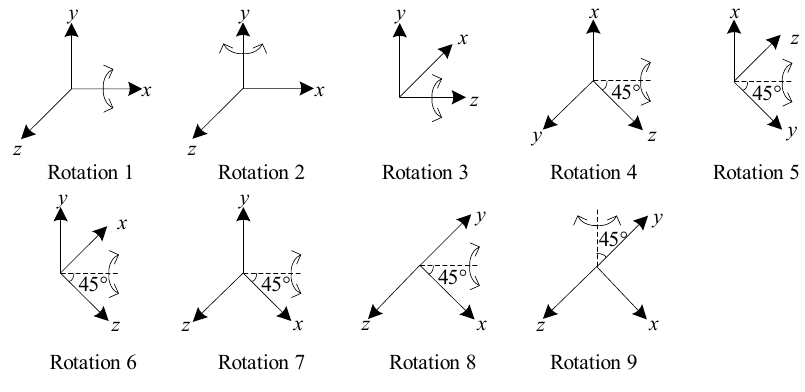
Figure 3. The 9 optimal rotation clusters.